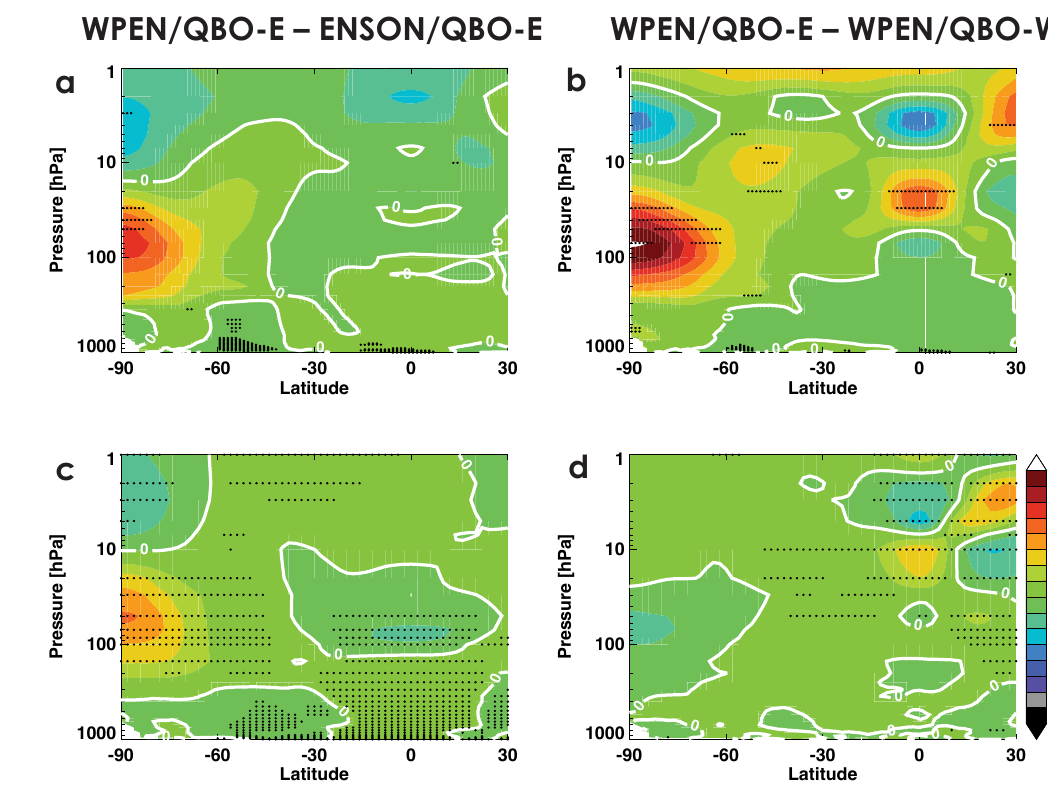
Fig. 4. November/December temperature differences (K) in (a, b) MERRA and (c, d) the GEOS CCM simulations. The response to WPEN events during QBO-E is shown in (a) and (c) . The response to the QBO phase during WPEN events is shown in (b) and (d) . White contours indicate zero difference. Black Xs indicate regions where differences are significant at the 95% confidence